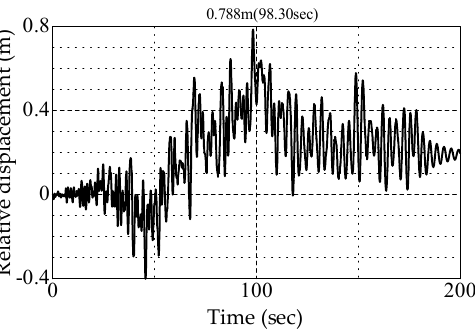
Figure 13. Horizontal displacement in ground surface: seismic motion (A).